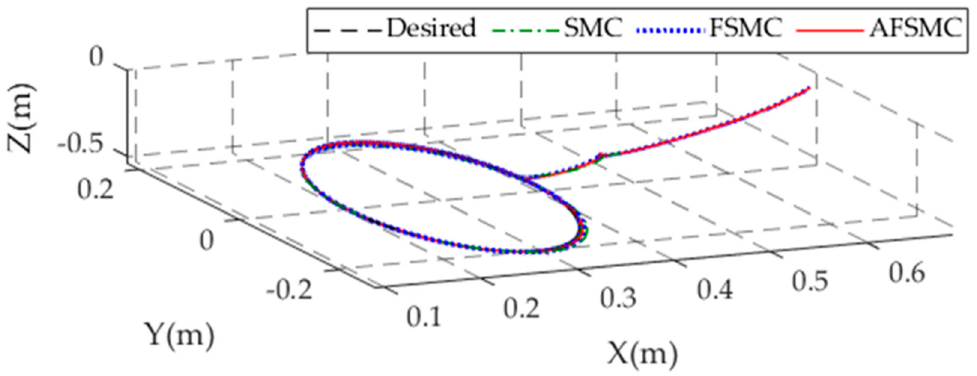
Figure 18. Response of the manipulator in 3D space.